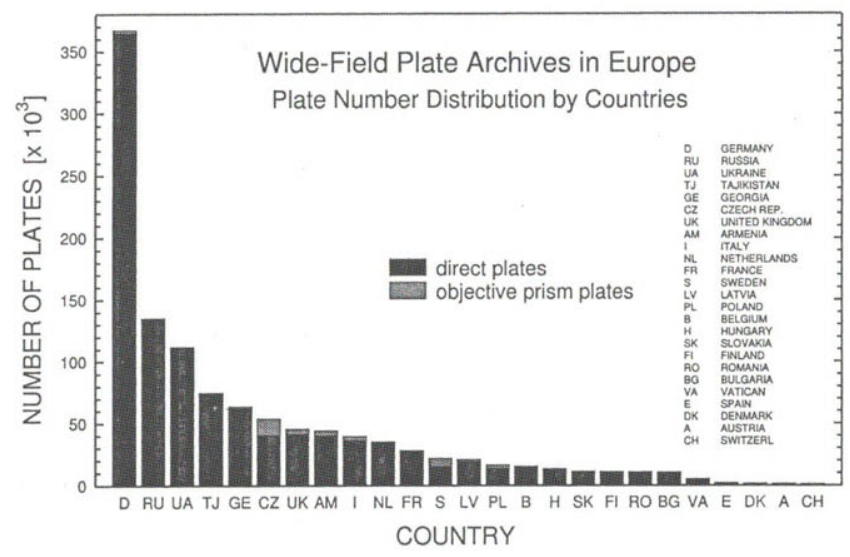
Fig. 2. Distribution of the number of wide-field plates by European regions.